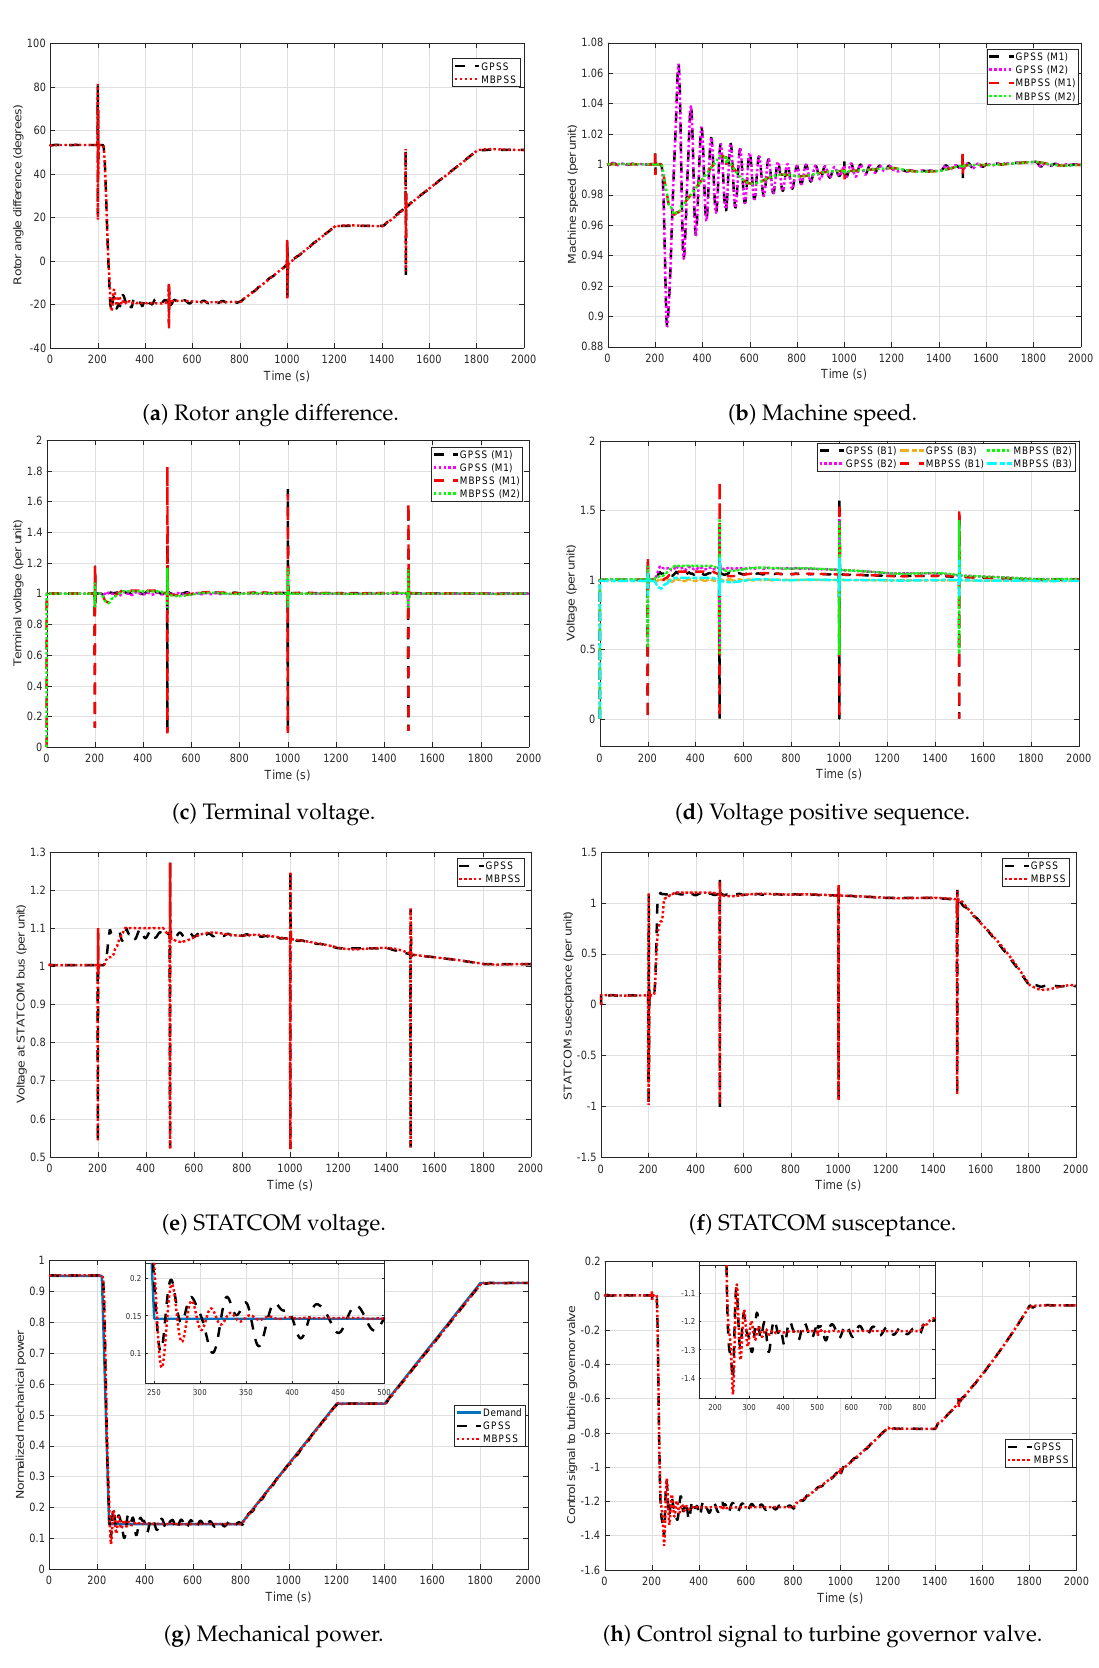
Figure 12. Case II.2: Variation of network signals during three-phase faults with generic and multiband PSS with static synchronous compensator